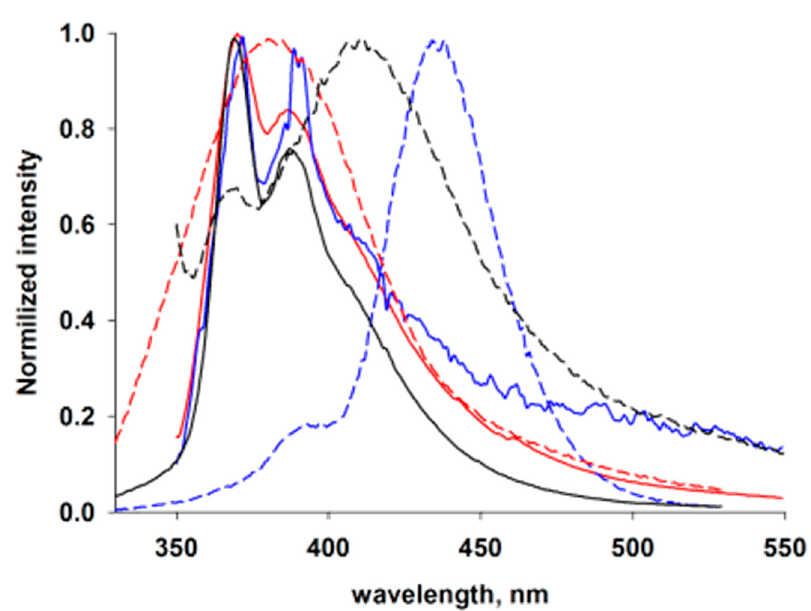
Figure 9. Normalized emission ( λ exc = 320 nm) spectra of complexes 1 (solid line) and 2a (dashed line) in the solution (black) and solid state at 298 K (red) and 77 K (blue).